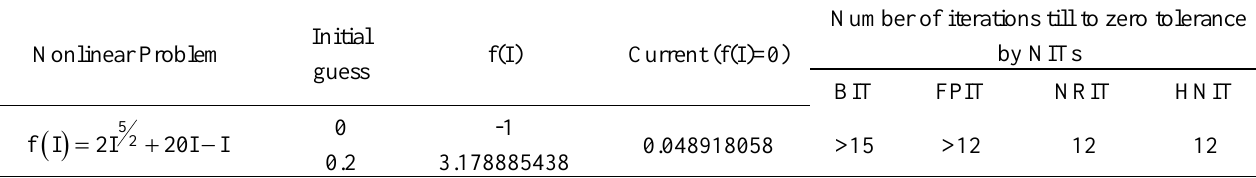
Solution of (iii) by NITs and comparison of the models.